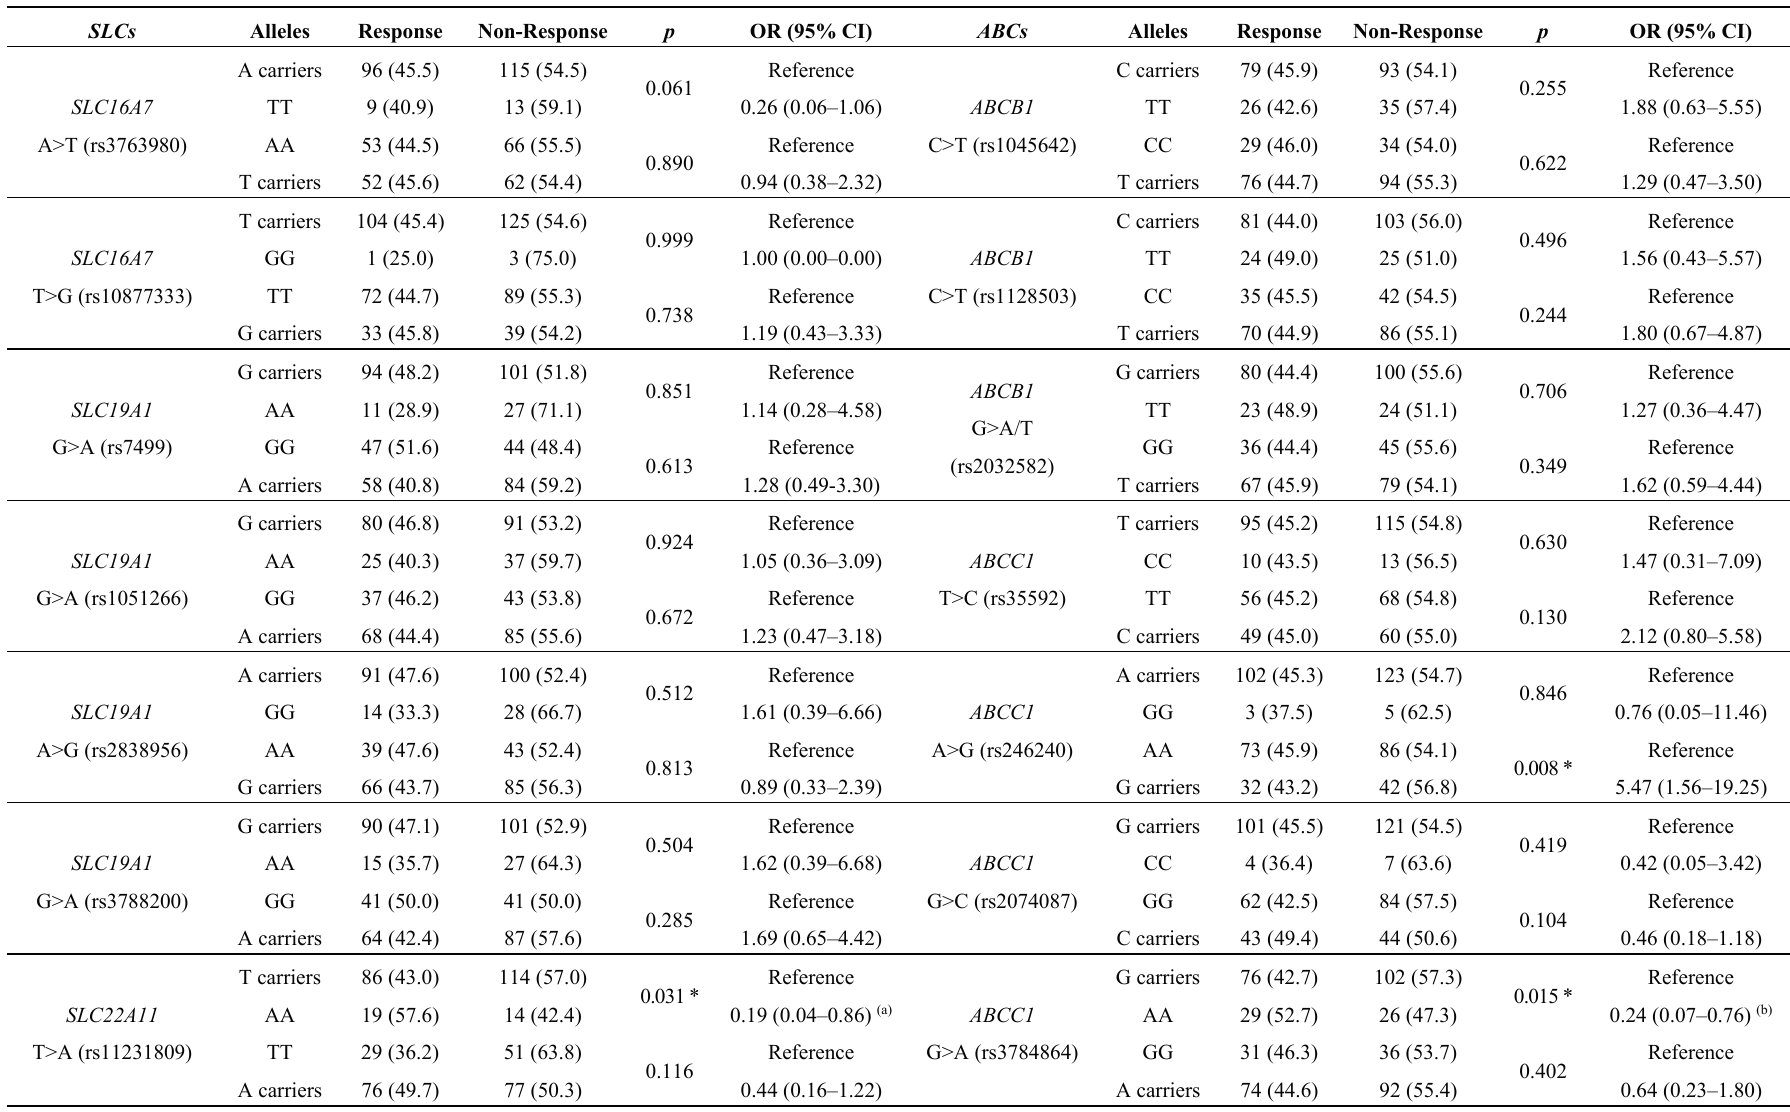
Table 1. Relation between single nucleotide polymorphisms (SNPs) in methotrexate (MTX) transporters genes and clinical response to MTX. SLCs Alleles